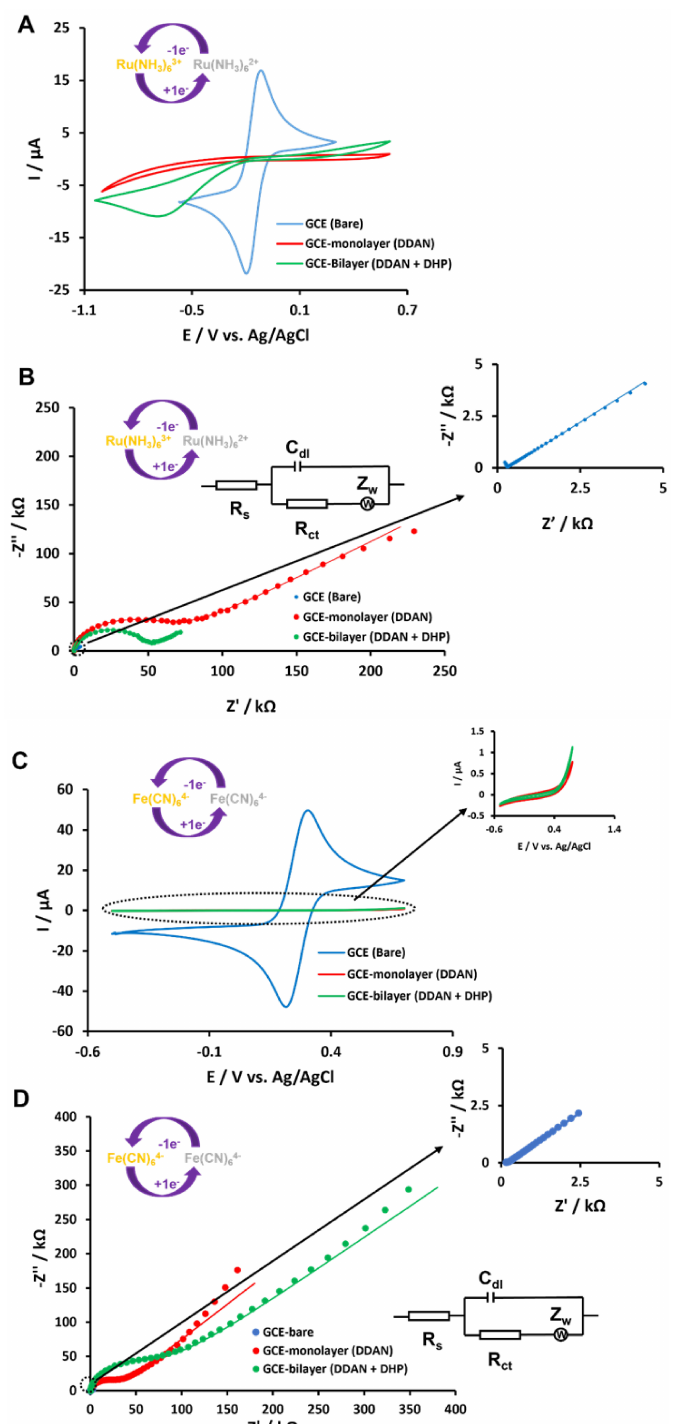
Figure 4. Cyclic voltammograms and Nyquist plots of the bare GCE, DDAN monolayer (the first layer), and DDAN-DHP bilayer. ( A , B ) show the respective CV at a scan rate of 50 mV s − 1 and EIS using [Ru(NH 3 ) 6 ] 3+ as the positively-charged redox probe. ( C , D ) show the respective CV and EIS spectra using [Fe(CN) 6 ] 3 − /4 − as the negatively-charged redox probe. In Nyquist plots, all dots represent the experimental data and solid lines represent the simulated data with the applied frequency from 100 MHz to 100 kHz. Insets in ( B , D ) show the Nyquist plots obtained from bare GCEs and the modified Randle’s equivalent circuit used to fit the data. The parameters of each circuit element are included in Table